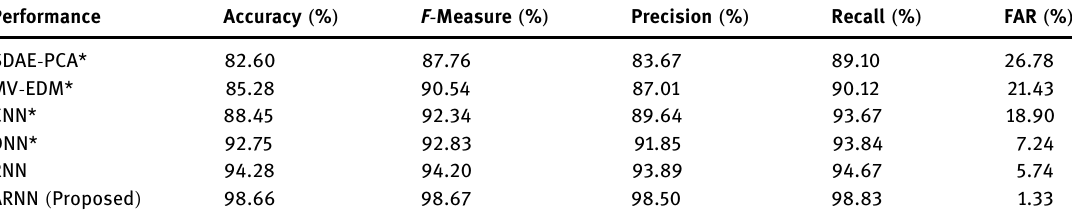
Table 3: Performance